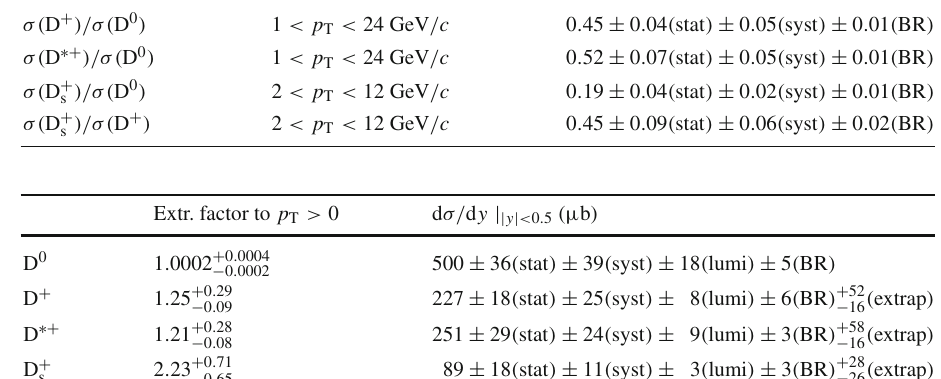
Kinematic range